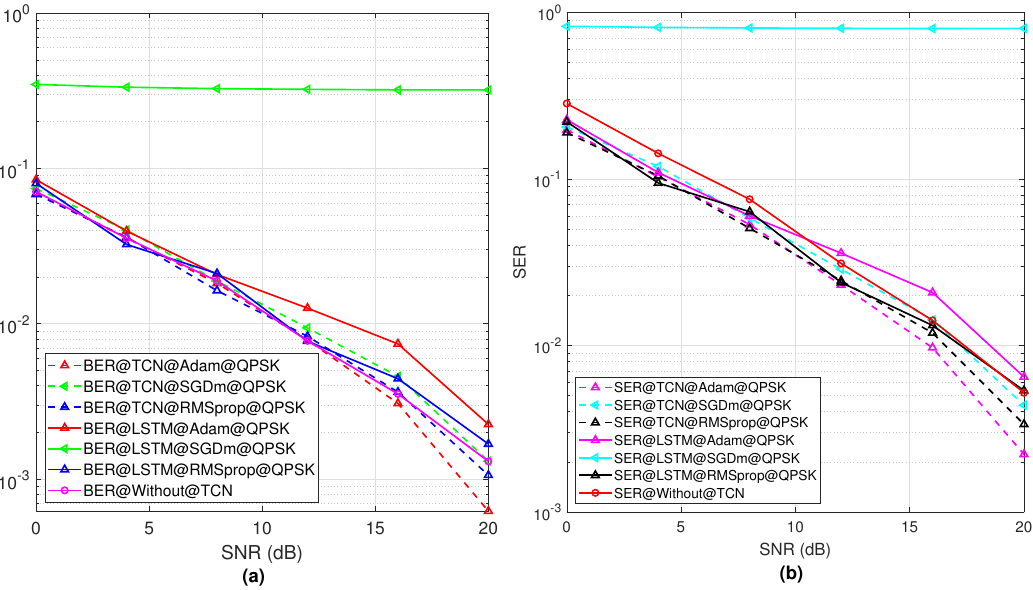
Figure 6. ( a ) The BER results with respect to SNR of different optimizers used for TCN model using QPSK modulation, ( b ) represents SER performance with respect to SNR values for the QPSK modulation scheme for different